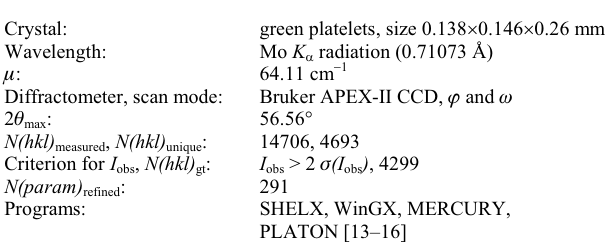
Table 1. Data collection and